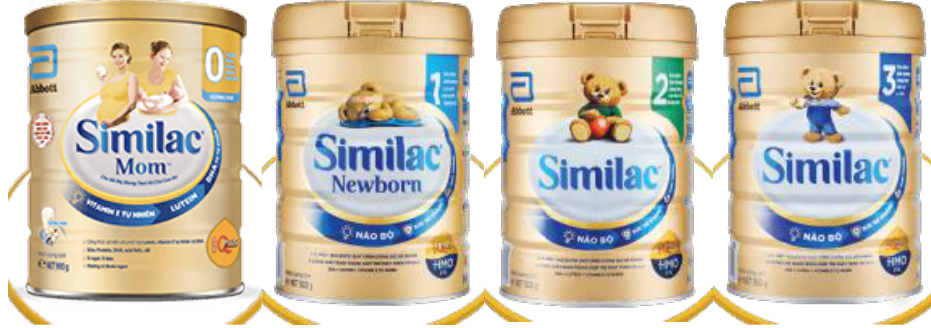
Nutrients 2021 , 13 , x FOR PEER REVIEW Figure 7. Cross-promotion of products in Similac Eye-Q product line, with almost identical packaging and labeling [8].